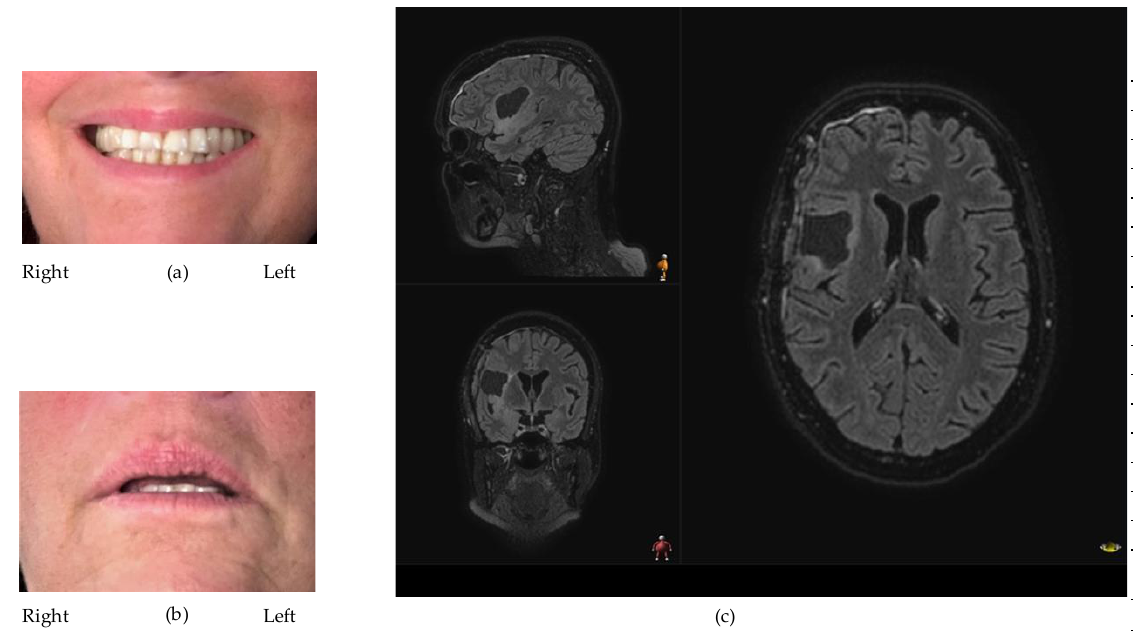
Figure 1. Both the photographs and the MR image (T2 Flair) depict the patient with the most severe facial motor deficit. ( a ) The patient has been instructed to show as big a smile as possible. A slightly less pronounced left furrow can be noticed. During the execution of the smile, the left side was slightly less responsive. ( b ) The patient was instructed to relax the face with a slight separation of the lips. A slight lowering of the left corner of the mouth can be noticed. ( c ) MR image (T2 Flair) of the resection cavity approximately 5 months postop.